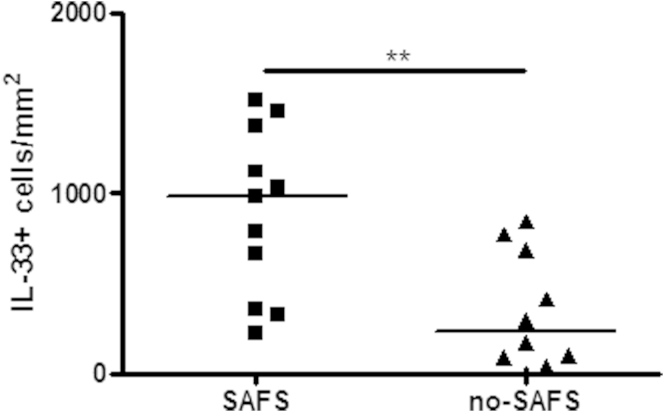
Endobronchial biopsy specimens from children aged 6 to 16 years with severe asthma receiving high-dose inhaled steroids only were stained by using immunohistochemistry for IL-33 expression. IL-33+ cells in the submucosa were counted and expressed per area of submucosa in children with SAFS compared with children with severe asthma without fungal sensitization (no-SAFS; n = 2). Group differences were assessed by using the Mann-Whitney U test: **P < .01.